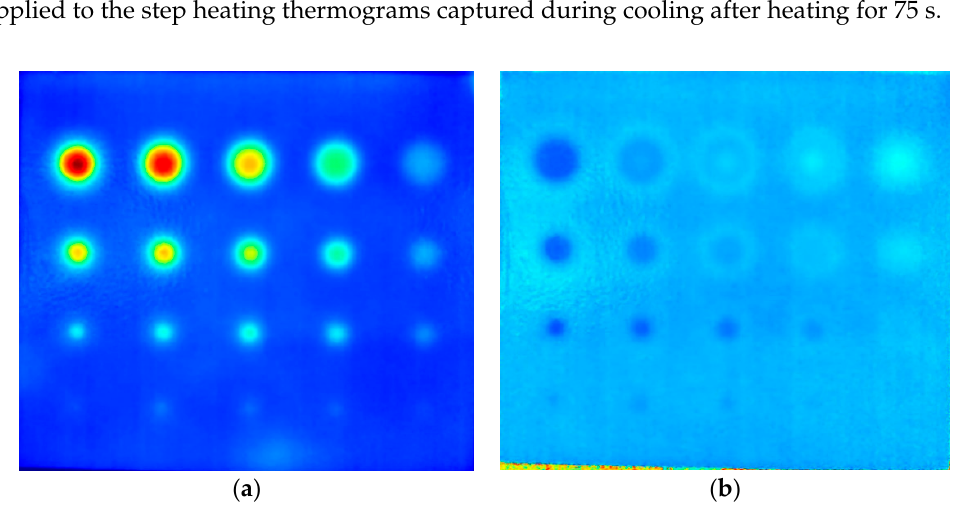
Figure 10. ( a ) Amplitude image and ( b ) phase image of the thermograms captured during cooling after 75 s of heating.